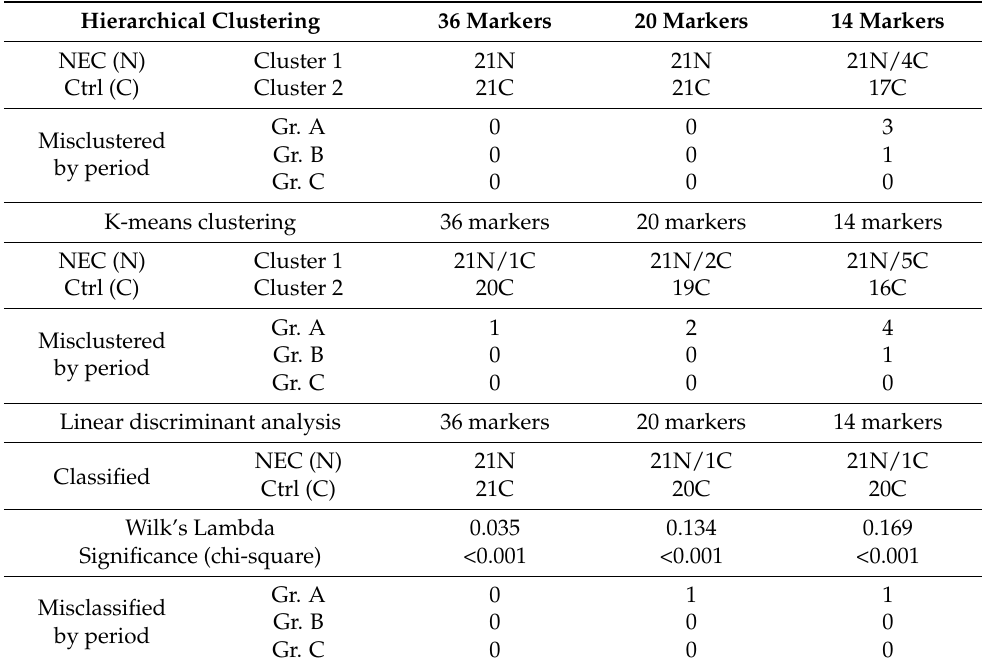
Table 3. Clustering and classification